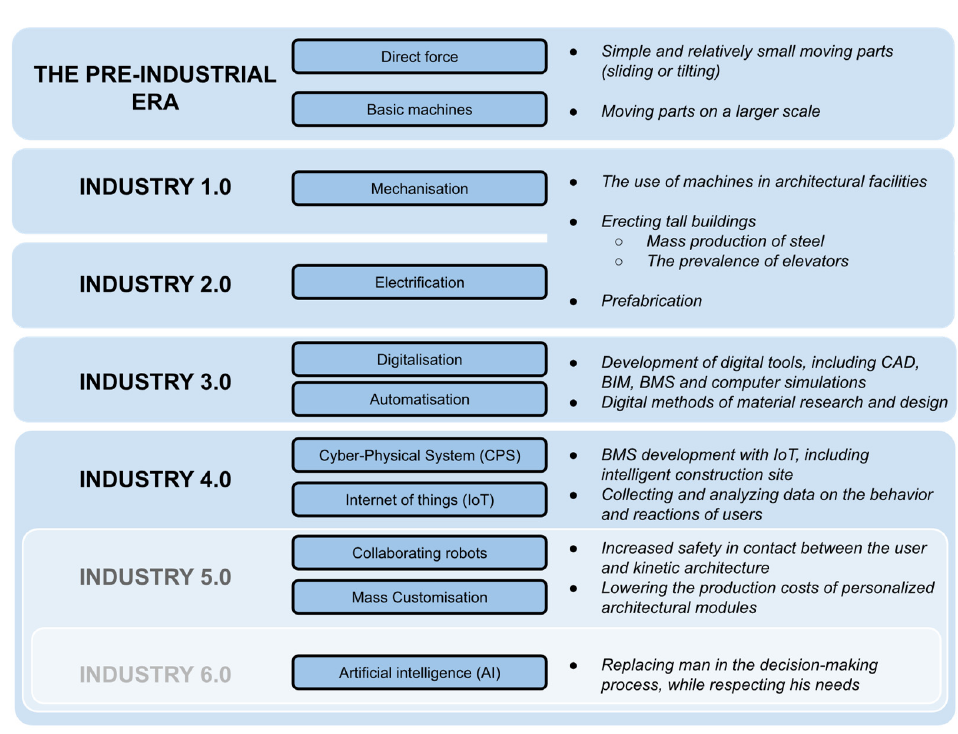
Figure 3. A summary of industrial revolutions with their basic slogans and key changes introduced in the field of mobile architecture and urban elements, based on our own previous studies [18].